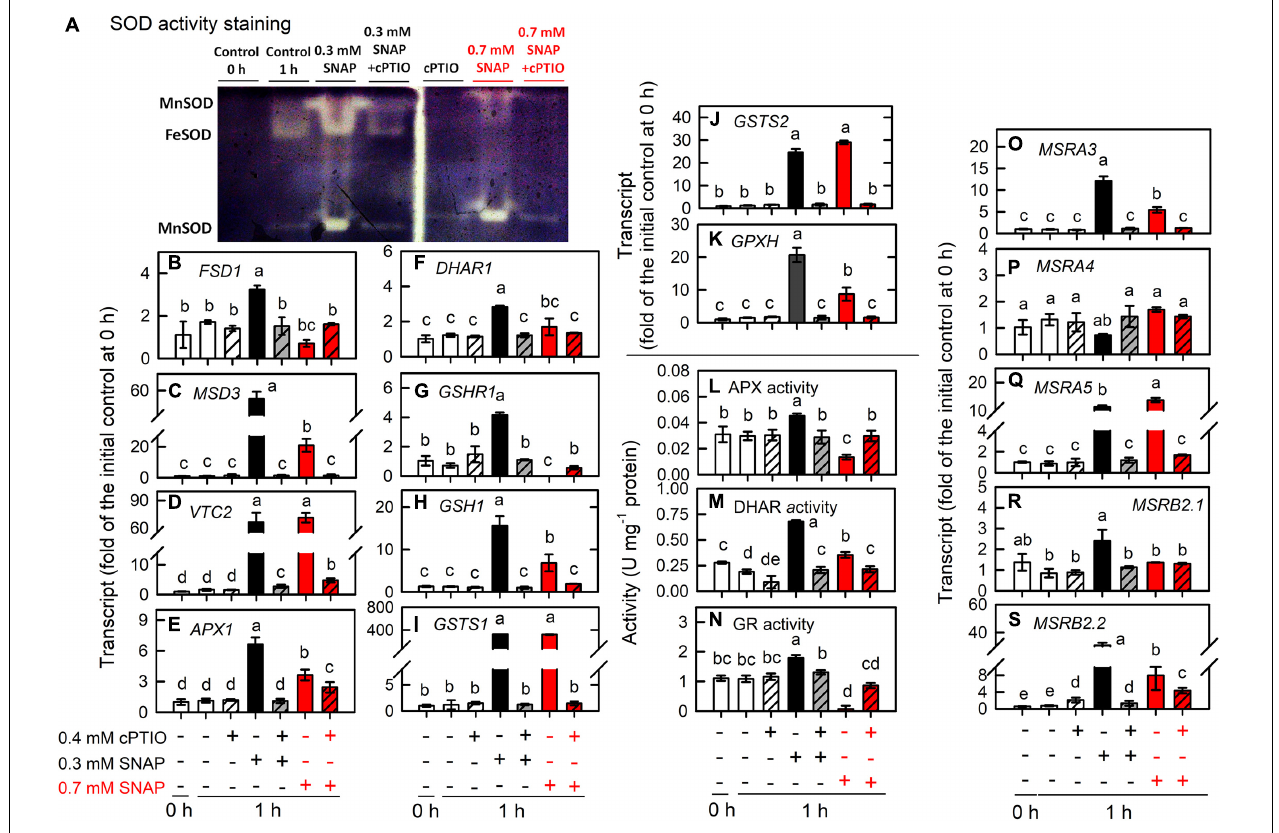
FIGURE 8 | Effects of 0.7 mM SNAP treatment on the expression of genes encoding proteins involved in antioxidant defense system. The transcript abundances of SOD activity assay (A) , FSD1 (B) , MSD3 (C) , VTC2 (D) , APX1 (E) , DHAR1 (F) , GSHR1 (G) , GSH1 (H) , GSTS1 (I) , GSTS2 (J) , and GPX5 (K) ; the activity of APX (L) , DHAR (M) , and GR (N) ; the transcript abundance of MSRA3 (O) , MSRA4 (P) , MSRA5 (Q) , MSRB2.1 (R) , and MSRB2.2 (S) in C. reinhardtii 1 h after exposure to 0.7 mM SNAP in the presence or absence of 0.4 mM cPTIO. Data are expressed as the mean ± SD ( n = 3). Different symbols indicate significant differences between treatments (Scheffe’s test, P <